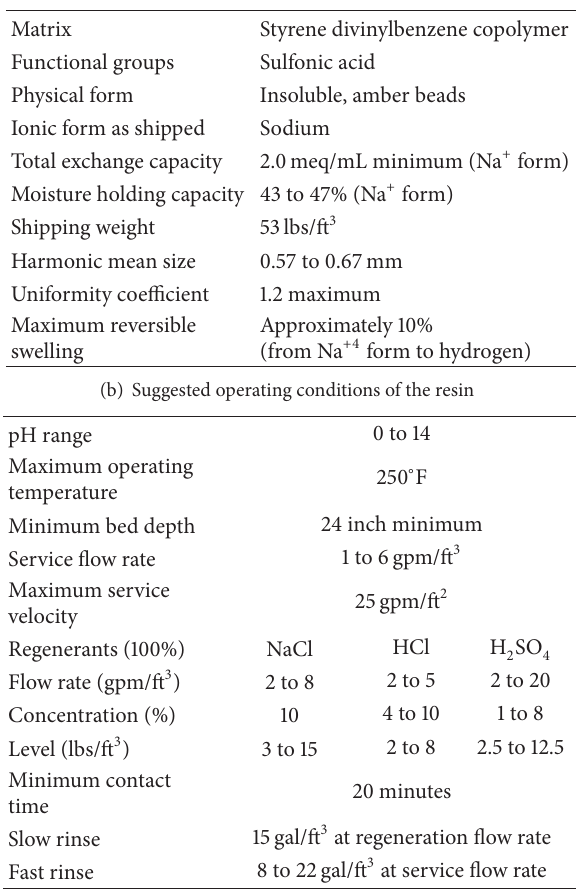
Table 1: Manufacturer data of the resin (Rohm and Haas 1998 [20]). (a) The properties of the resin, Amberjet